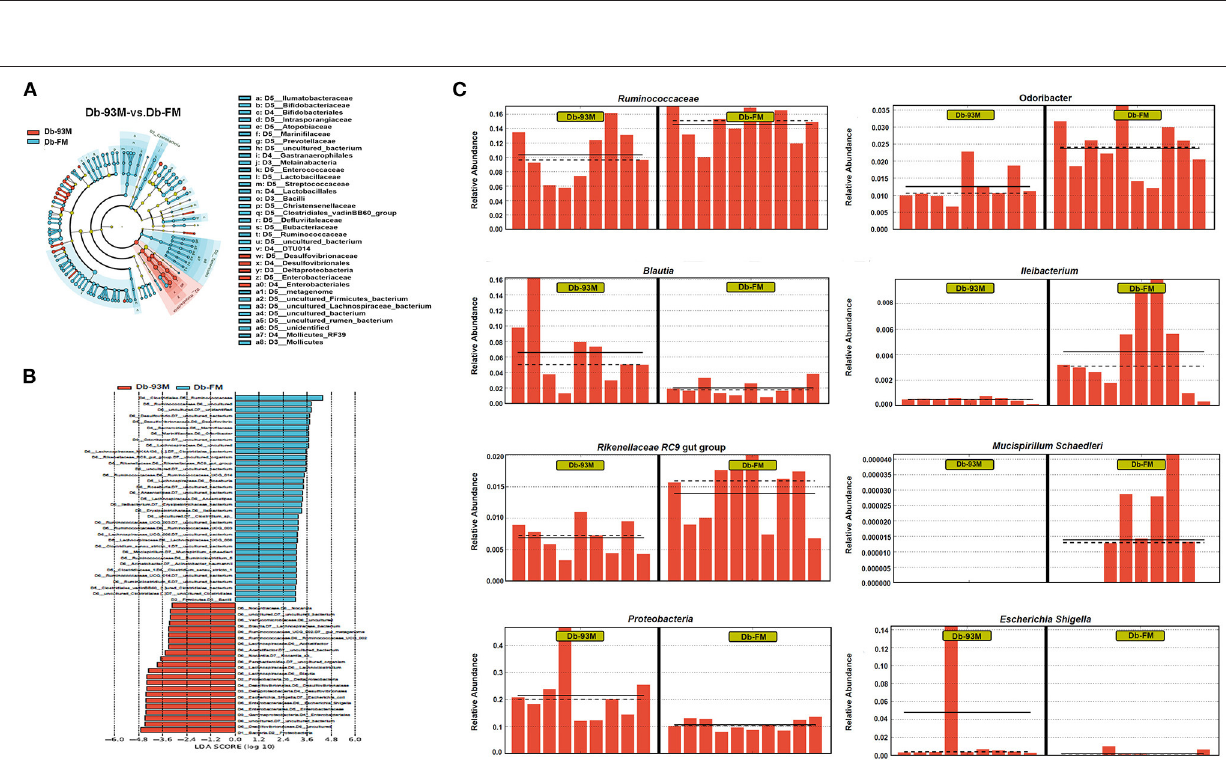
Frontiers in Nutrition | www.frontiersin.org 8 June 2022 | Volume 9 | Article